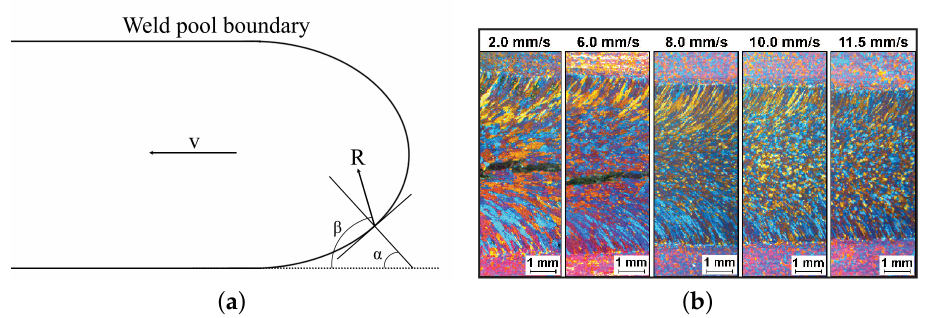
Figure 3. Effect of process parameters on grain morphology and cracking in aluminum arc welding. ( a ) Relationship between travel speed v and growth rate R . α is angle between torch travel direction and melt pool normal. β is angle between torch travel direction and actual solidification